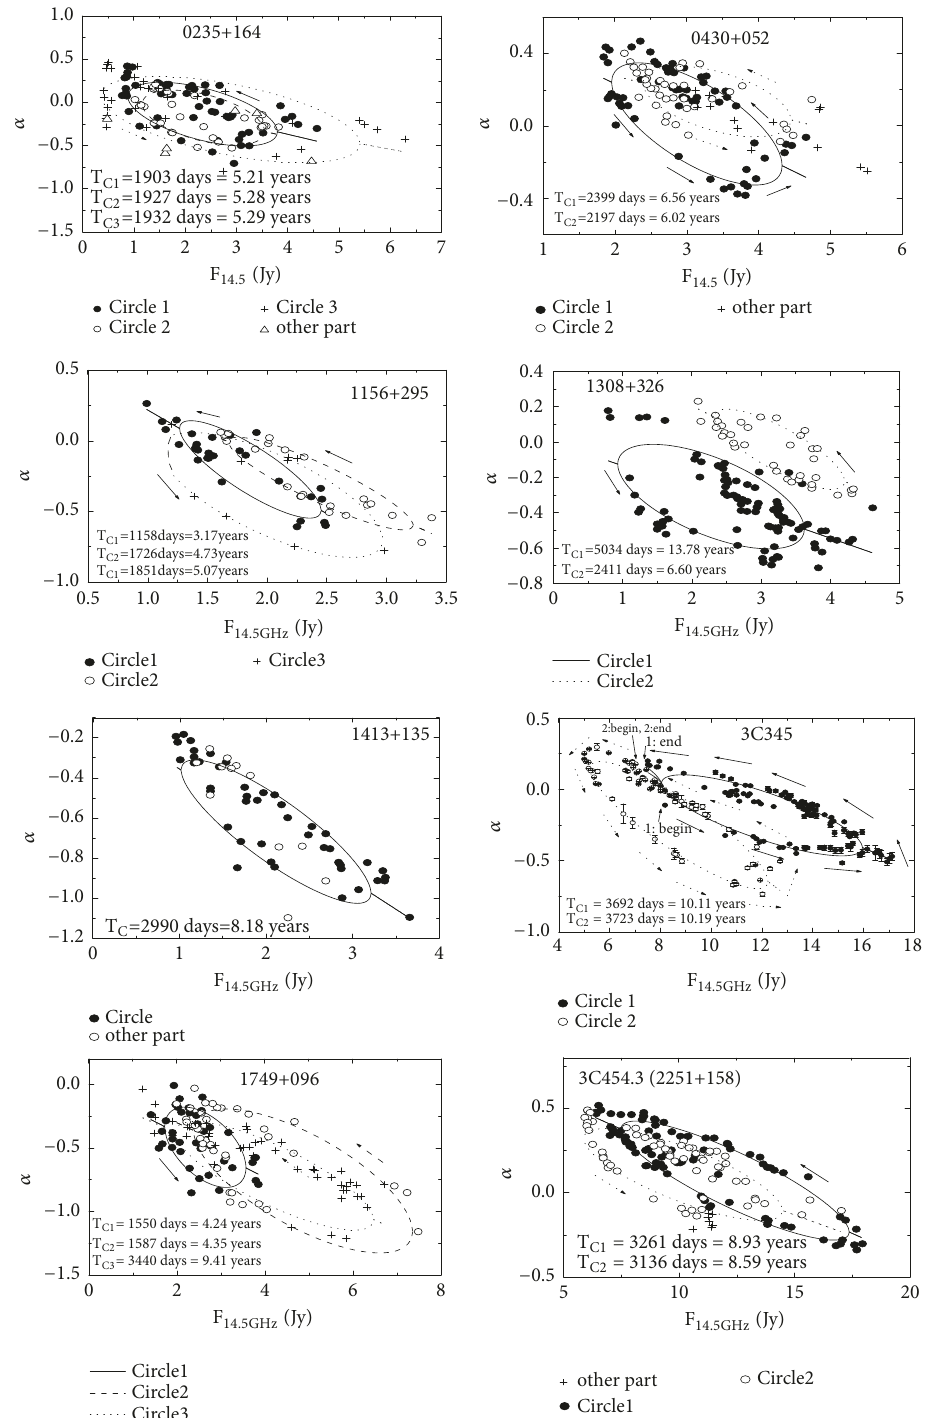
Figure 3: The 𝛼 − 𝐹 14.5 circles of the target sources. The elliptic solid lines, dotted lines, and dashed lines indicate the elliptic fit results based on the time